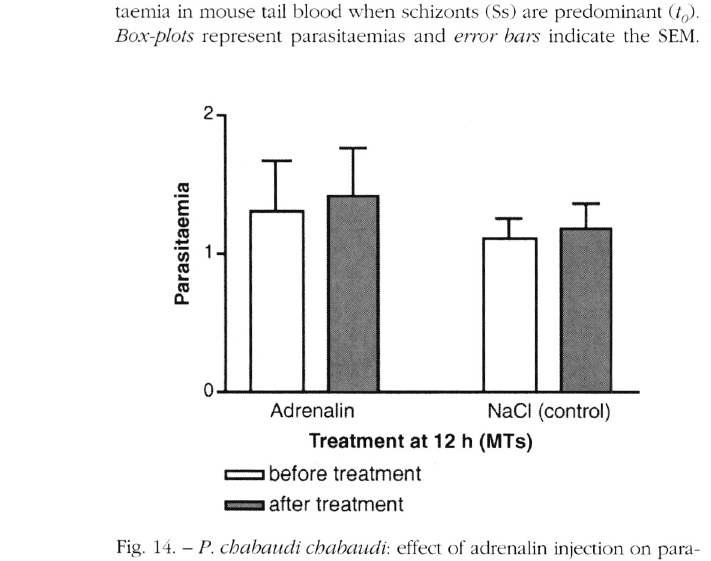
Fig. 13. - P. vinckei petteri: effect of adrenalin injection on parasi­ taemia in mouse tail blood when schizonts (Ss) are predominant ( t0 ). Box-plots represent parasitaemias and error bars indicate the SEM.